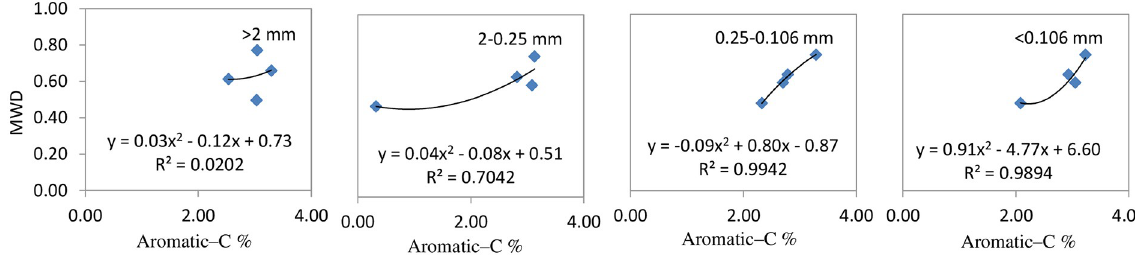
Fig 6. Regression models of aromatic–C and soil aggregate stabilities for different particle sizes.